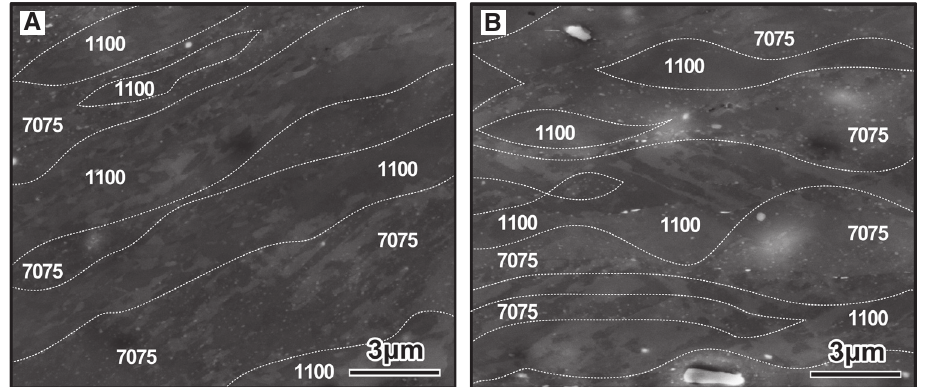
Figure 5 SEM-BSE micrographs of TD section of the processed 1280 layer composite sheets (A) showing ultrafine structure in the layers after 75% cold rolling, (B) showing coarsened structure after 75% cold rolling and then annealing at 150 ° C for 30 min. The particles (50–100 nm in size) distributed in 7075 layers were identified as the equilibrium precipitate MgZn